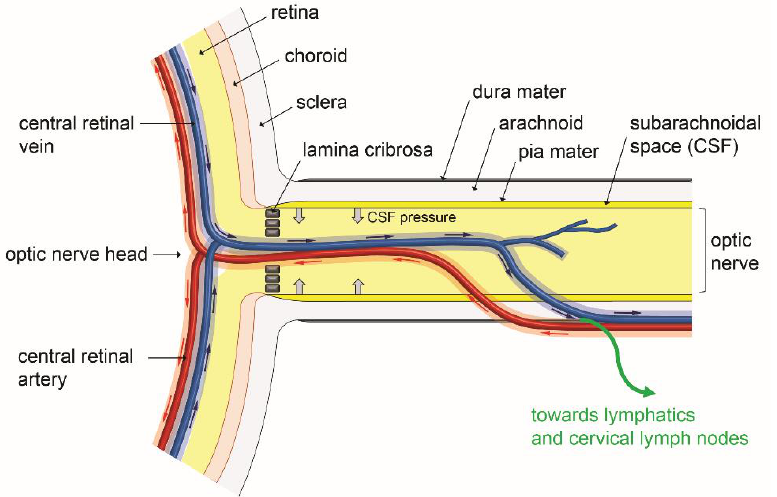
Figure 5. Overview of glymphatic system involvement in fluid transport in the posterior eye. Para- arterial influx (red arrows) and paravenous efflux (blue arrows) occurring in the paravascular spaces of the main retinal artery and vein may respectively bring solutes and eliminate waste products in the eye retinal layers. After further transport in the paravascular spaces of the optic nerve vein, waste metabolic products may enter true lymphatics and move towards cervical lymph nodes. These fluid movements may be affected by the hydrostatic pressure of CSF (cerebrospinal fluid) which is present in the subarachnoidal space and which could exert mechanical forces (large gray arrows) interfering with the paravascular fluid circulation in the glymphatic system. Scheme inspired from